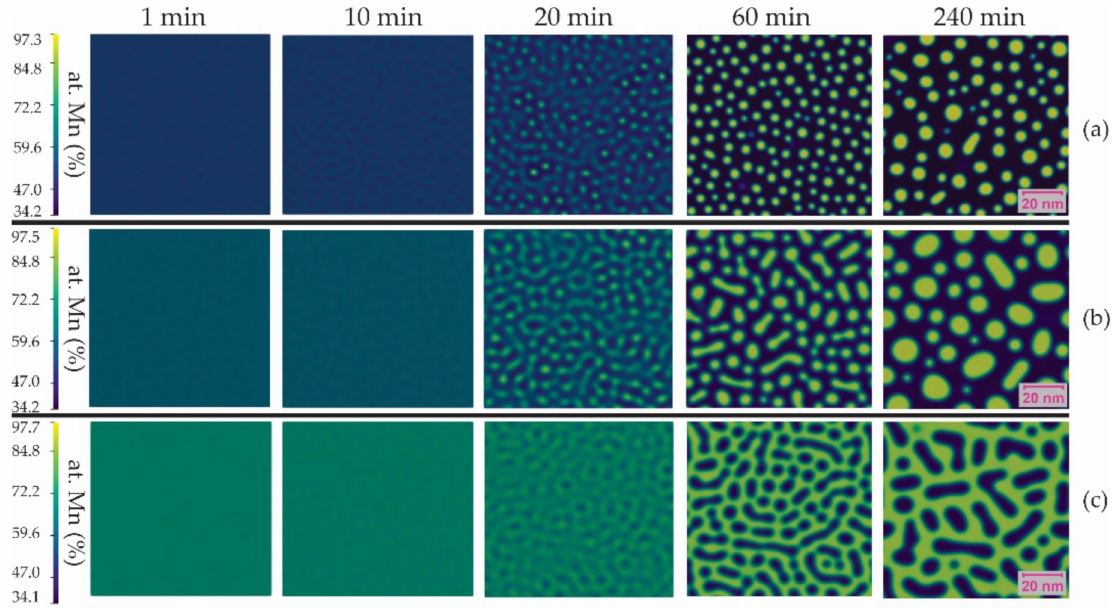
Figure 6. Microstructural evolution of ( a ) Mn-40 at. %Cu, ( b ) Mn-30 at. %Cu, and ( c ) Mn-20 at. %Cu alloys aged at 500 ◦ C for different